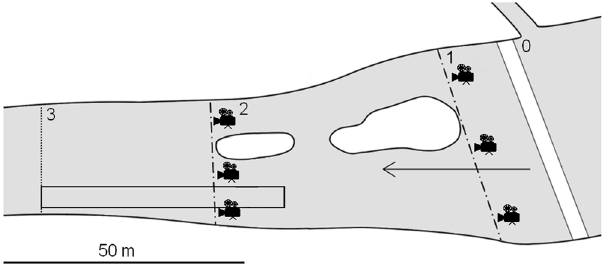
Figure 4. Schematic representation of the spawning ground located downstream of the weir. The space between the weir (0, solid lines) and the dotted line represents the estimated spawning ground 27 . Electrofishing was performed within a 50 m transect visualized by the rectangle. Dot-dashed lines represent position of video monitoring sites for 2015 (site no. 1) and 2016 (site no. 2). Within each site symbolized by camera illustration, three cameras were placed randomly. At sites no. 1, 2 and 3, water velocity was computed using daily mean water discharge data. Four monitoring tiles were deployed at each site, and eggs were counted and removed daily. Arrow shows the direction of flow. The figure was generated by the software ArcMap, version 10.2.2 51